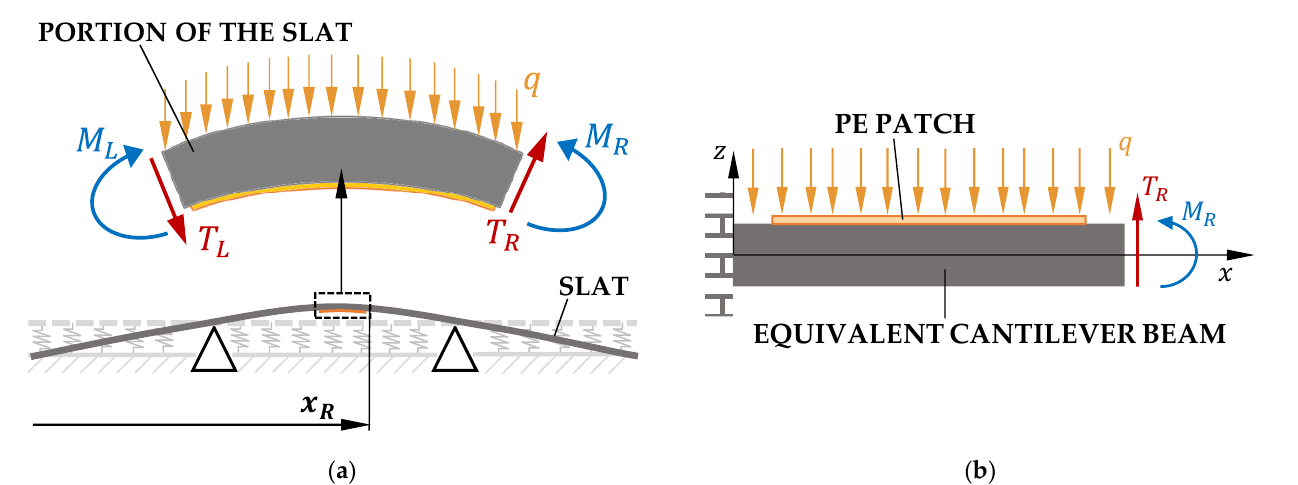
Figure 10. ( a ) Equilibrium of a portion of the slat.; ( b ) equilibrium of the equivalent cantilever beam. The OCV generated by the PE patch depends on the strain distribution within the patch. Since the PE patch is very thin compared with the slat thickness, it is assumed that the strain distribution within the patch coincides with the strain distribution of the slat just below the patch. In this scenario, the OCV generated by the PE patch bonded to the slat can be reproduced by simply bonding the patch to an underlayer, which reproduces the same strain distribution of the slat just below the patch. By assuming a 1D approximation, the strain distribution S ( x ) along the longitudinal direction of the slat subject to a bending moment distribution M f ( x ) can be approximated as